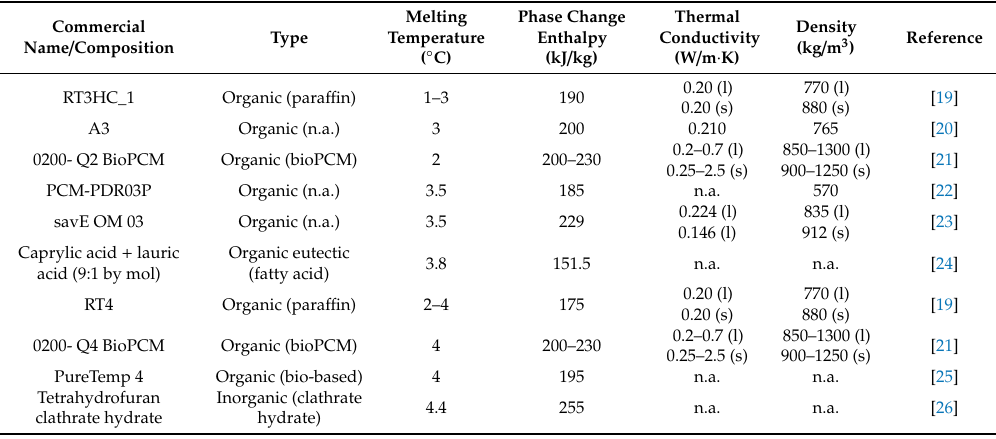
Table 3. Pre-selected available phase change material (PCM) for the Mediterranean system and some of their thermophysical properties as reported in the